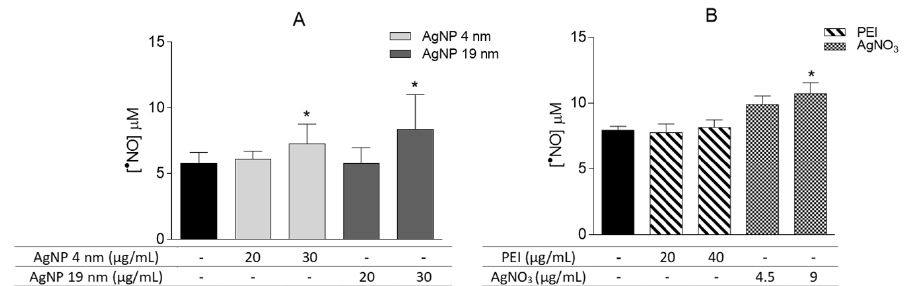
Figure 11. Effects of 4 nm (20 and 30 µg/mL) and 19 nm (20 and 30 µg/mL) AgNP. ( A ) and PEI and